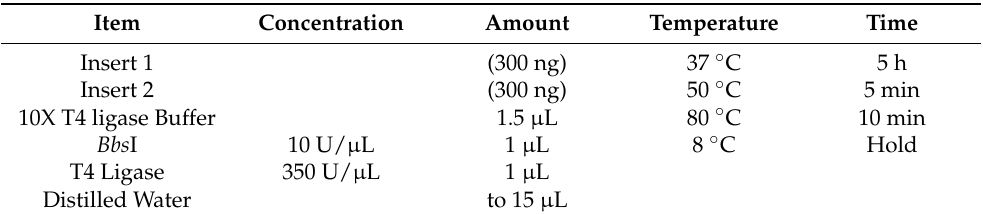
Table 5. Golden Gate reaction components and thermal conditions.